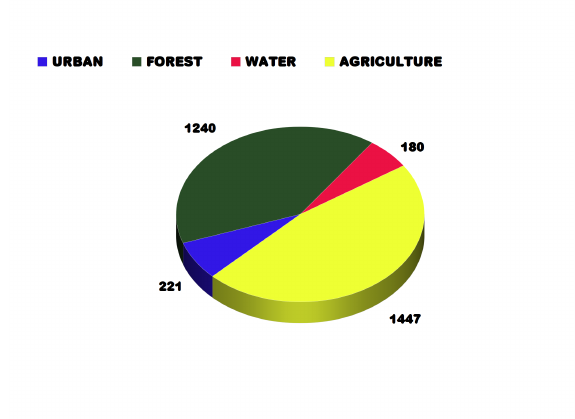
Figure 5: Area of each landcover classes by CART